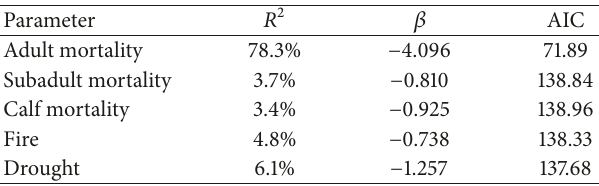
Table 4: Relative importance of age-specific mortalities and catas- trophes on roan population viability. The parameters 𝑅 2 (coefficient of determination) and 𝛽 (regression coefficient) and AIC are derived from generalized linear models